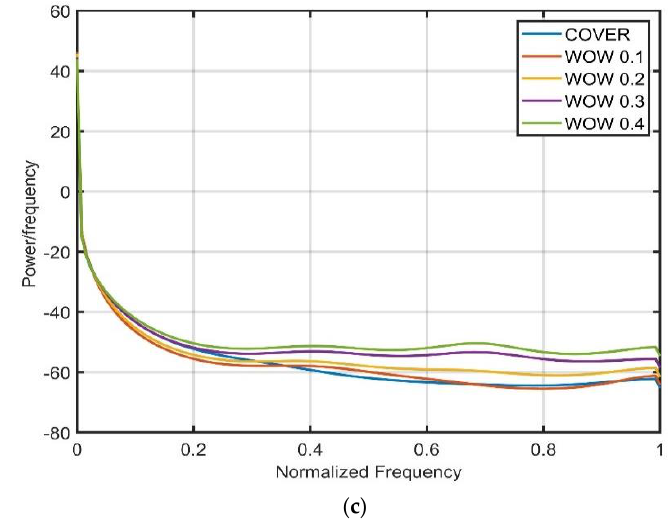
Figure 5. Entropy covariance plots of the cover and stego-images. ( a ) Covariance plot of the cover and HILL. ( b ) Covariance plot of the cover and S-UNIWARD. ( c ) Covariance plot of the cover and WOW. Table 1. Percentage increase of the pixels modified after high-boost